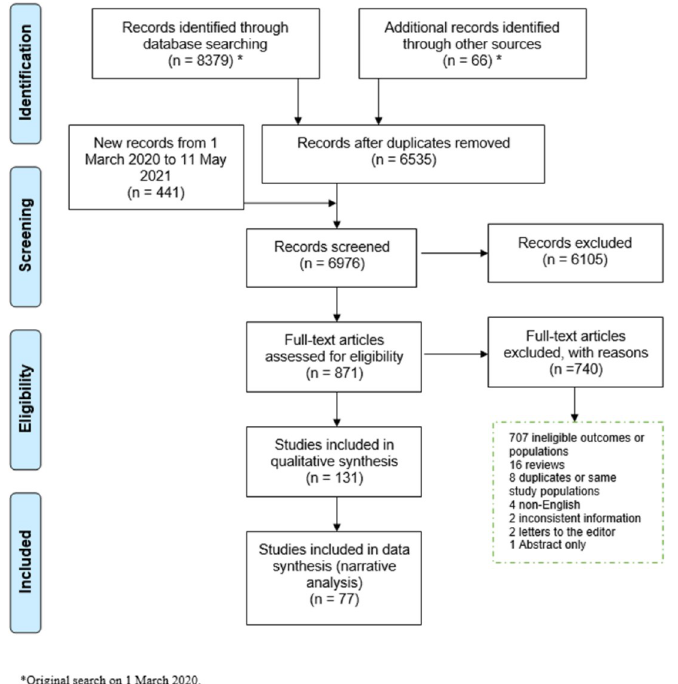
Fig 1. PRISMA flowchart diagram for study